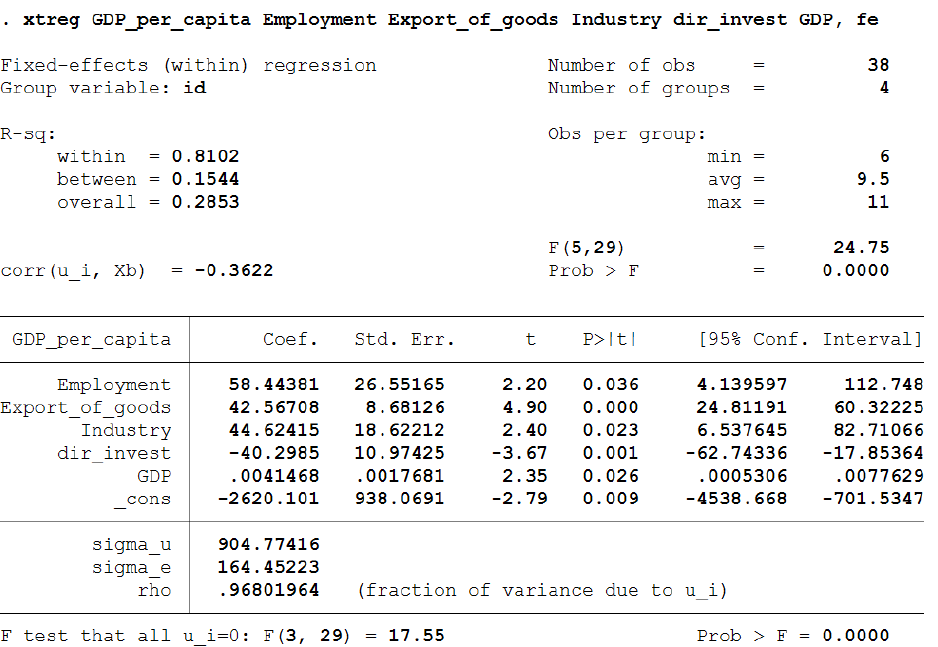
Figure 2. Results of the assessment of the economic development model in countries trying to join the EU (fixed effects)